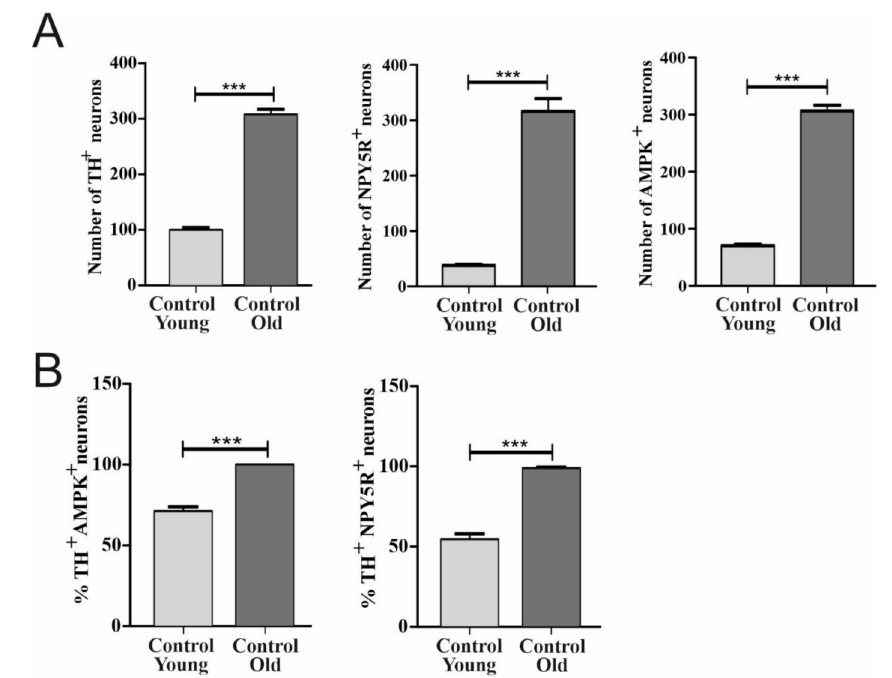
Figure 2. Effects of age on the distribution of TH, AMPK, and NPY5R in CVLM neurons. The numbers of neurons containing TH, AMPK, and NPY5R in CVLM were compared between age groups ( A ). Further analysis was conducted to show the colocalization of TH+/AMPK+ and TH+/NPY5R+ in the same brain region ( B ). Each bar and associated error bar represent the mean value of neuronal number ± SEM from one experiment ( n = 3 per group). *** ( p < 0.001) represents a significant difference between control groups of young rats and old rats,